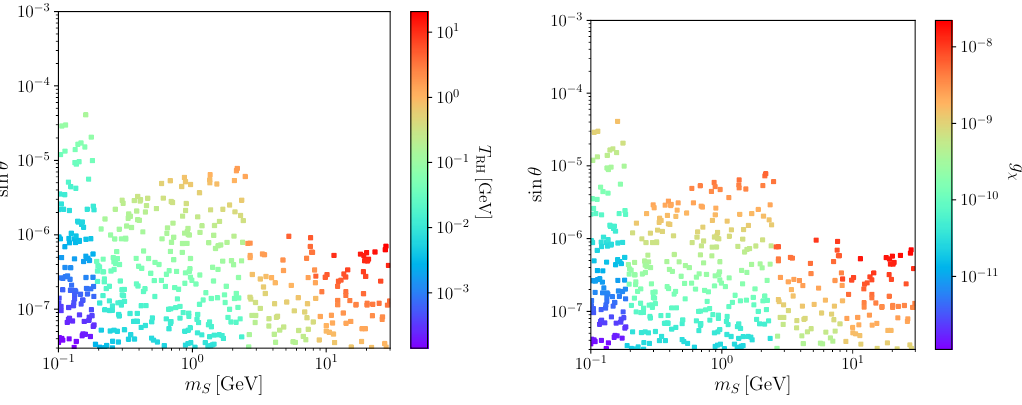
Figure 4 . Scan over the energy fraction η , the reheaton decay width Γ S and the dark-matter mass m DM . We assumed w kin = 1 and excluded points for which the Freeze-In production of DM exceeds 1% of the total relic